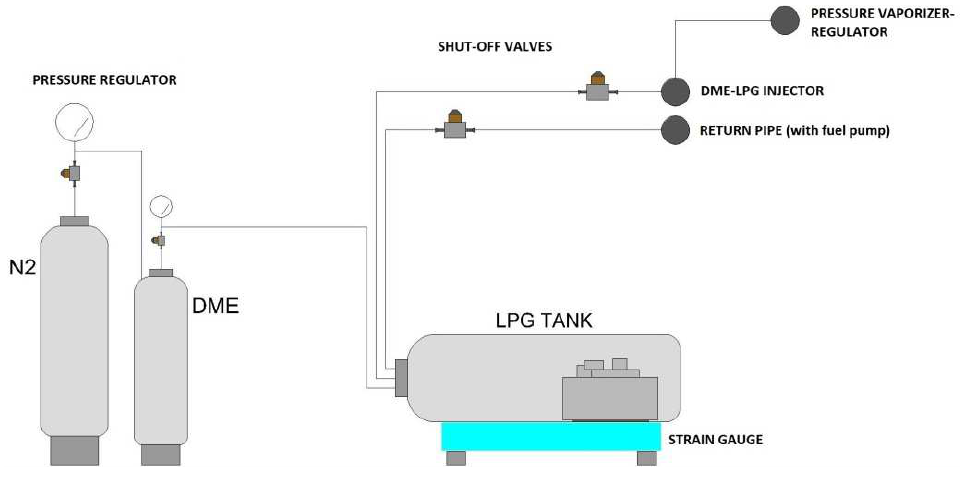
Figure 1. LPG-DME mixture preparation system [25].